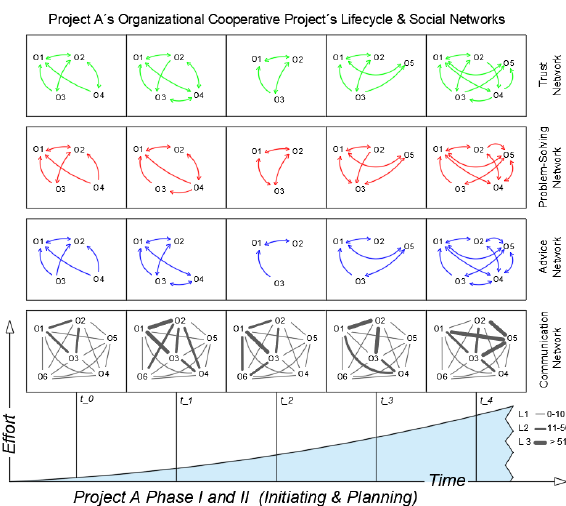
Figure 3. Results of the application of the proposed model to project´s A initiating and planning phases.